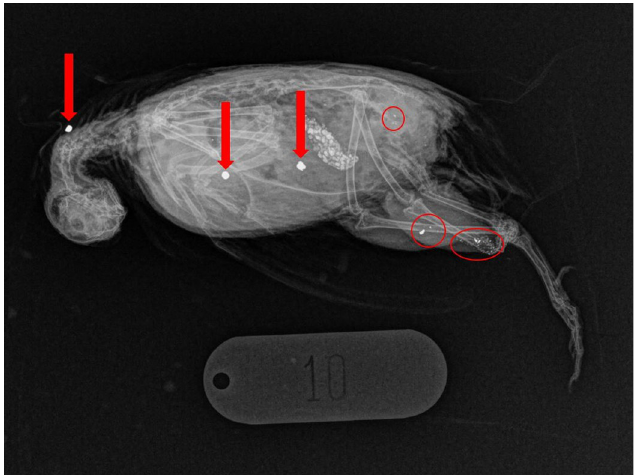
Fig 2. Embedded lead shot (large bright white objects) and fragmentation centers (red circles) detected via radiography in a harvested stubble quail ( Coturnix pectoralis ): Three pellets and three fragmentation centers are visible in this